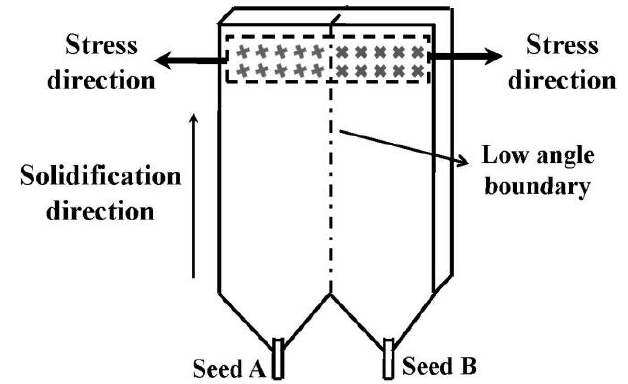
Figure 1. Schematic diagram of the preparation of the specimen with LABs.